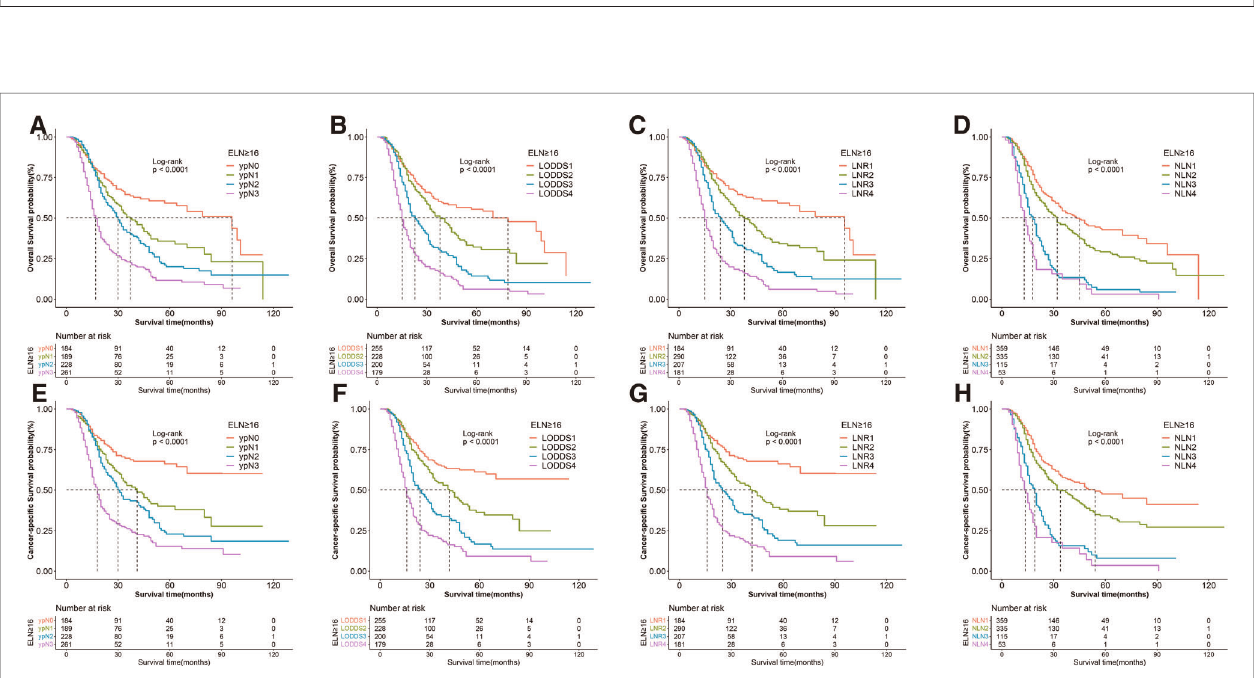
FIGURE 5 | Kaplan – Meier survival curves of OS according to ( A ) ypN ( B ) LODDS, ( C ) LNR, and ( D ) NLN staging system and CSS according to ( E ) ypN, ( F ) LODDS, ( G ) LNR and ( H ) NLN staging system for gastric adenocarcinoma patients after NAT with ELN<16. OS, overall survival; CSS, cancer speci fi c survival; LNR, lymph node ratio; LODDS, log odds of positive lymph node; NLN, negative lymph node; NAT, neoadjuvant therapy.